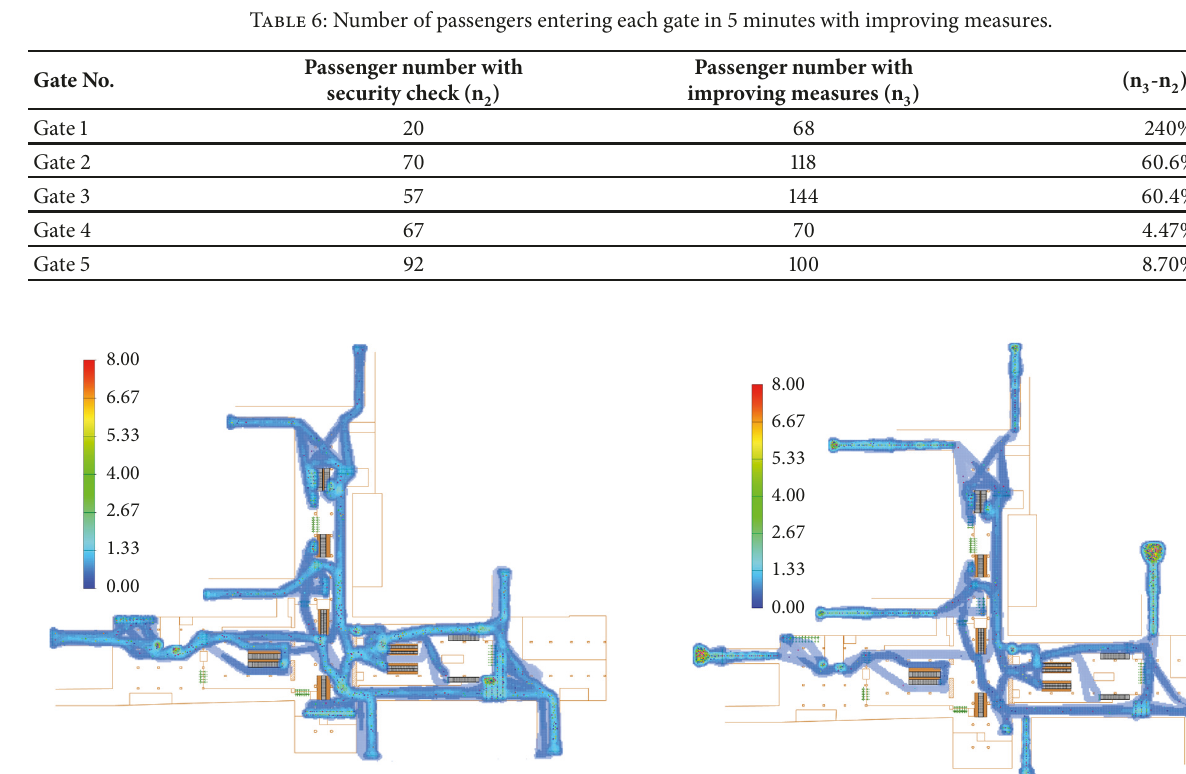
Figure 5: Crowd density map without security checks (in 5 minutes).